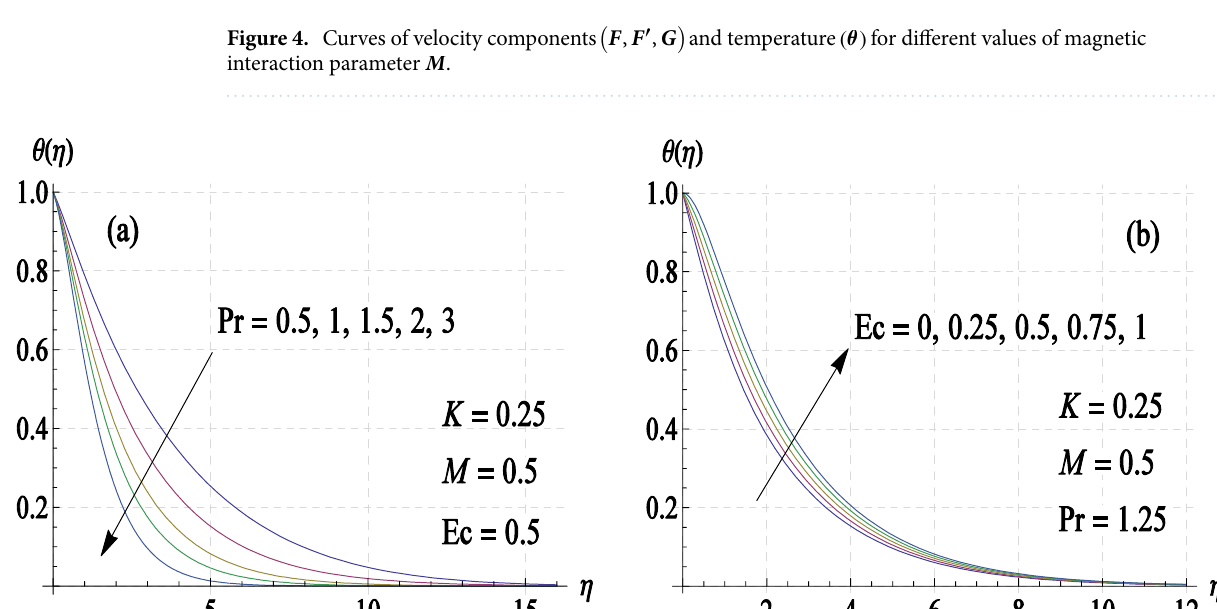
Figure 5. Temperature curves for different values of ( a ) Prandtl number Pr and ( b ) Eckert number Ec